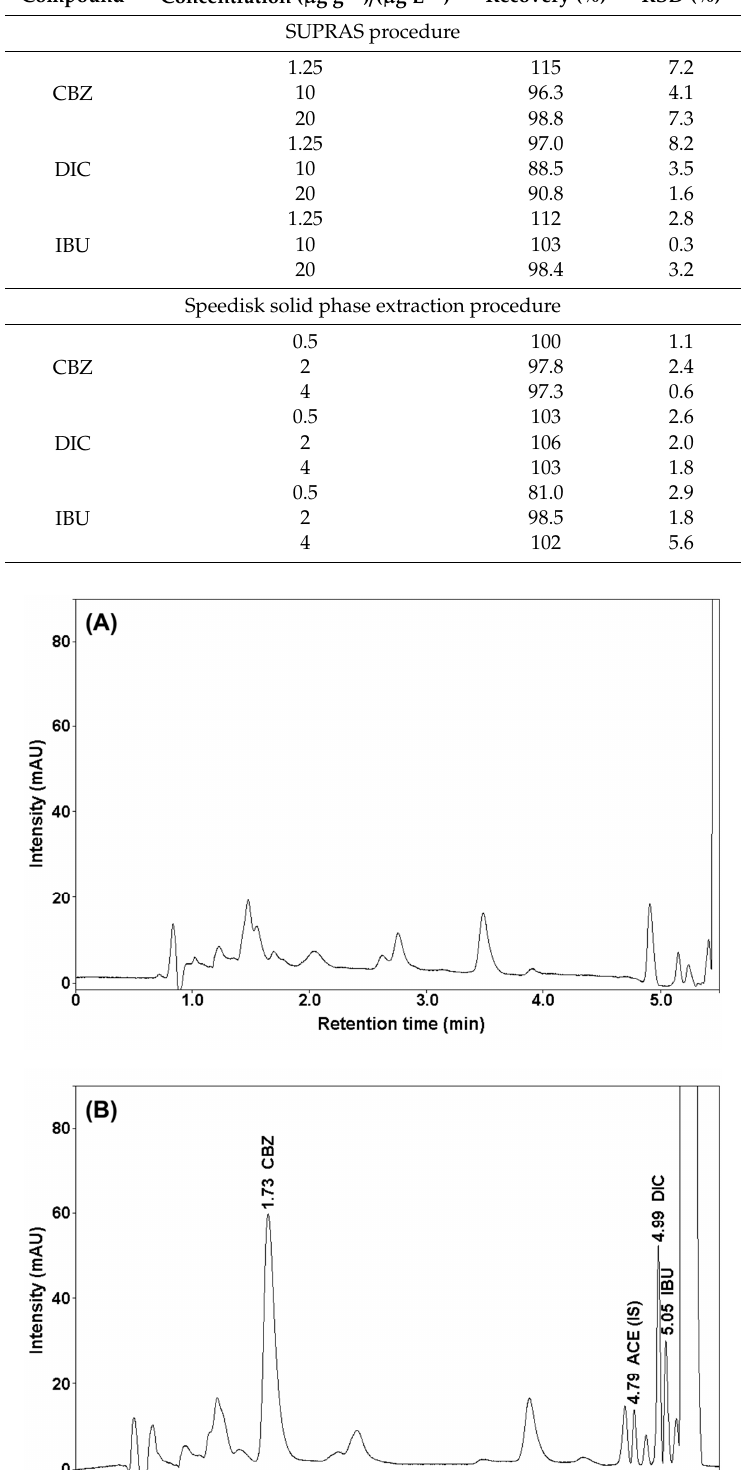
Table 1. Drug recovery after applying the developed SUPRAS procedure and Speedisk solid phase extraction procedure ( n = 6).